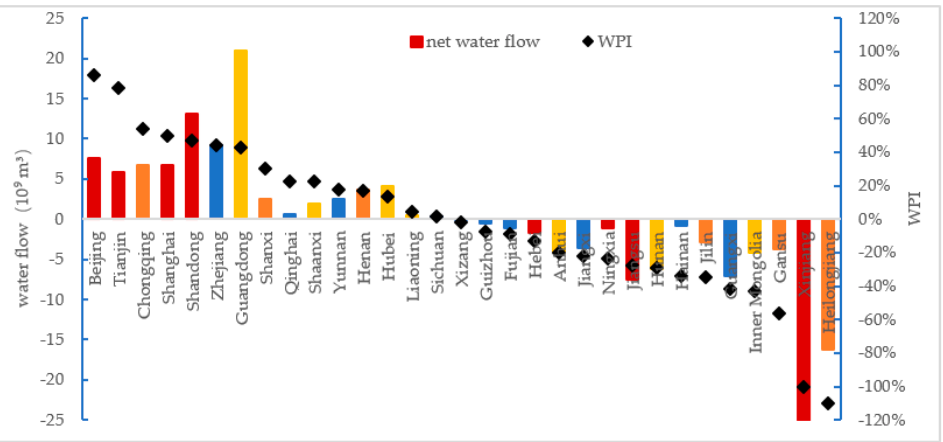
Figure 5. The water plunder index and water scarcity index of each province. Note: The columns marked in red, orange and yellow indicate that provinces are under extreme, severe, moderate water shortage, respectively; and the points marked in blue indicate that there is no water shortage.